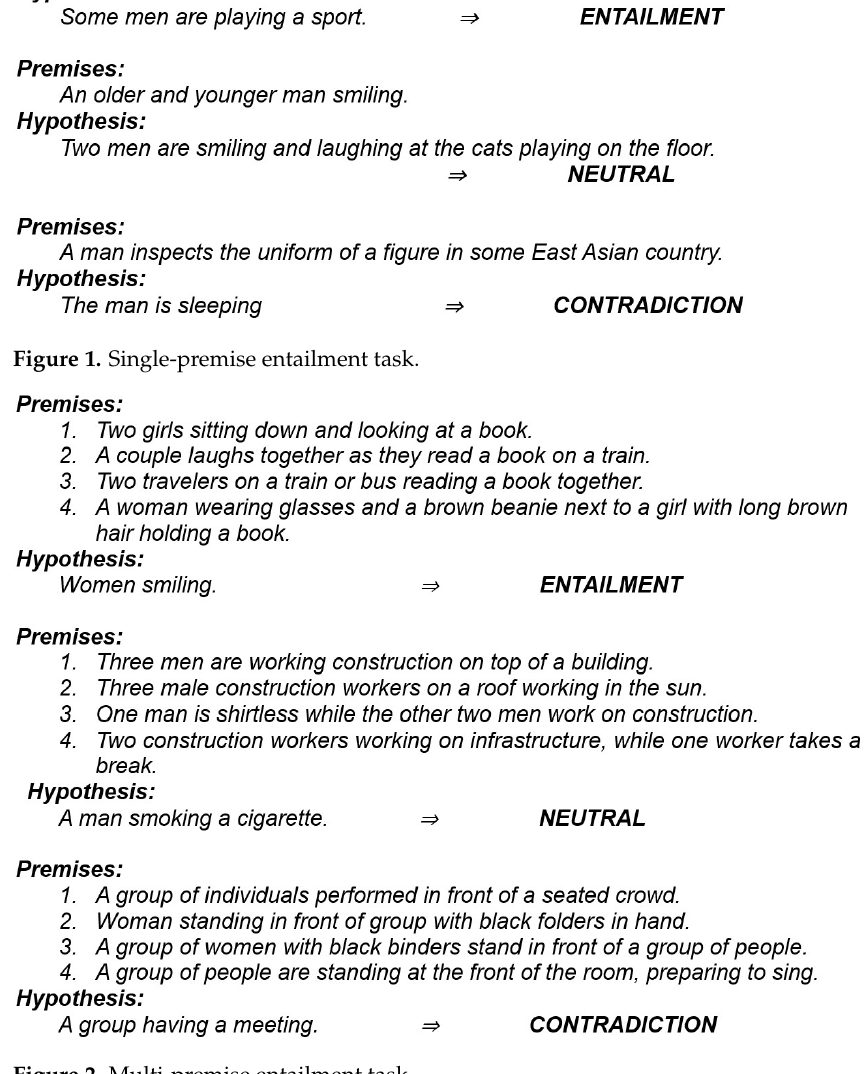
Figure 2. Multi-premise entailment